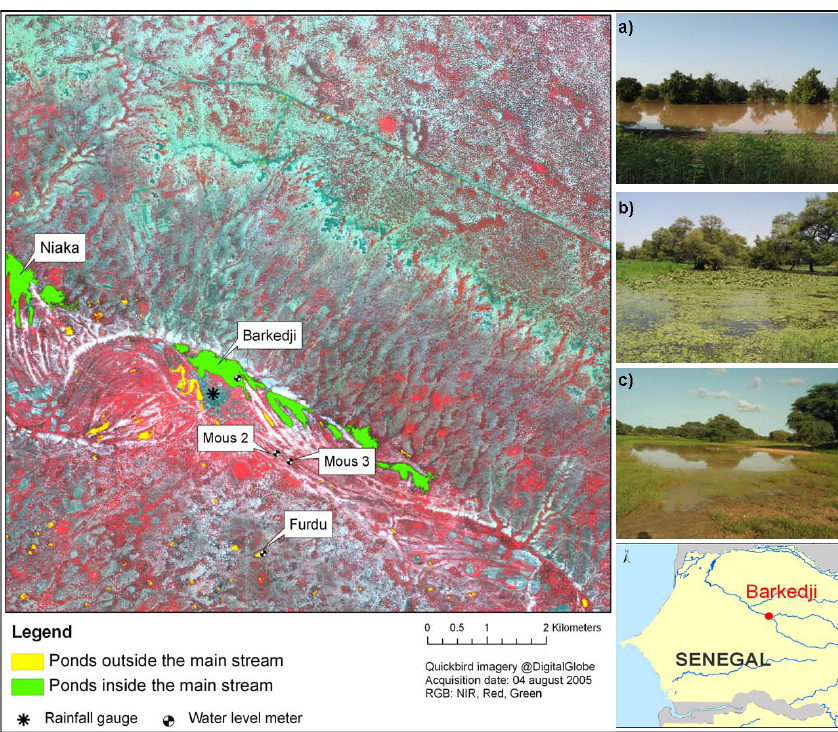
Fig. 1. Quickbird image of the study area showing location of ponds, rain gauge and water level meters near Barkedji village, Ferlo Region, Senegal. (a) Barkedji, (b) Furdu and (c) Mous3 ponds in September